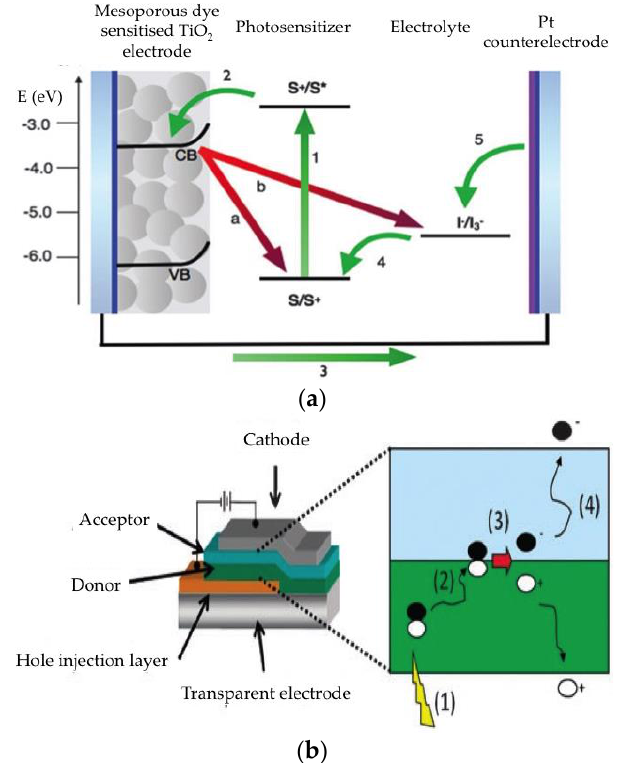
Figure 6. Schematic representation of the composition and charge transfer processes in ( a ) DSSC [(1) light absorption; (2) electron injection; (3) electron collection; (4) reduction of the oxidized dye cation by the redox couple; (5) regeneration of the electrolyte at the counterelectrode] and ( b ) OSC [(1) Light absorption and creation of an exciton; (2) exciton diffusion; (3) exciton splitting at the interface; (4) diffusion and collection of charges]. Reproduced with permission of [61] and [65], respectively.